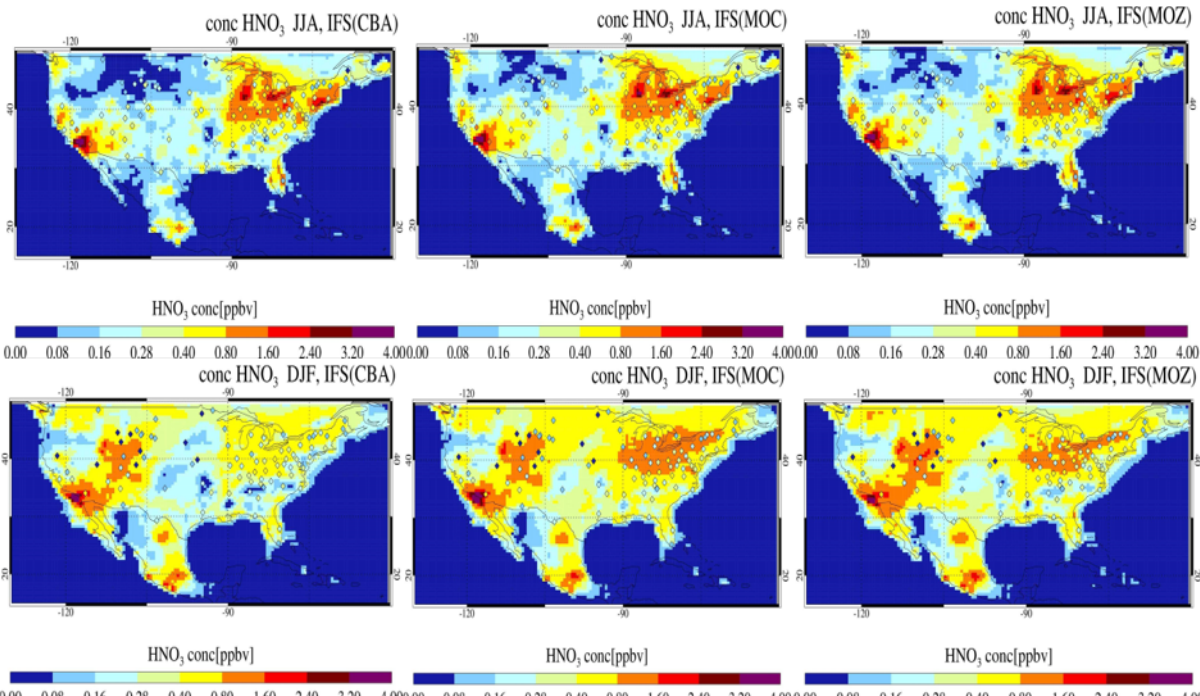
Figure 18. The seasonal mean distribution of surface mixing ratios for gas phase HNO 3 across the US and Canada for JJA (top) and DJF (bottom) against seasonal composites of observations taken from the CASTNET network. The observational mean values and locations of the measurement stations are given as the diamonds located in each panel.